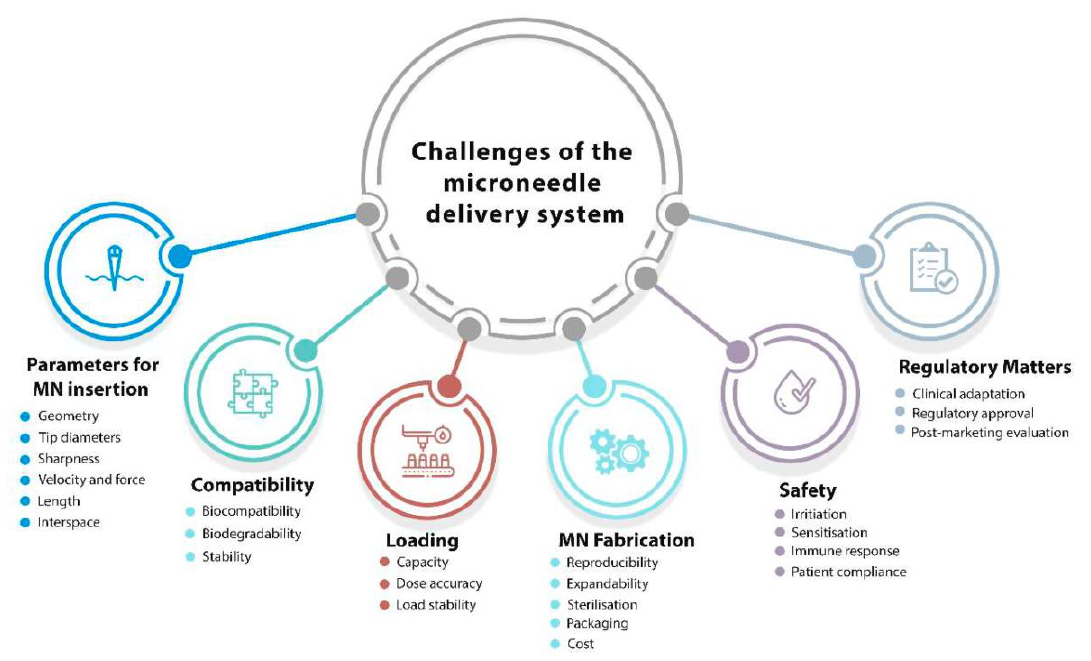
Figure 6. Factors affecting the development of microneedle-based delivery [46].